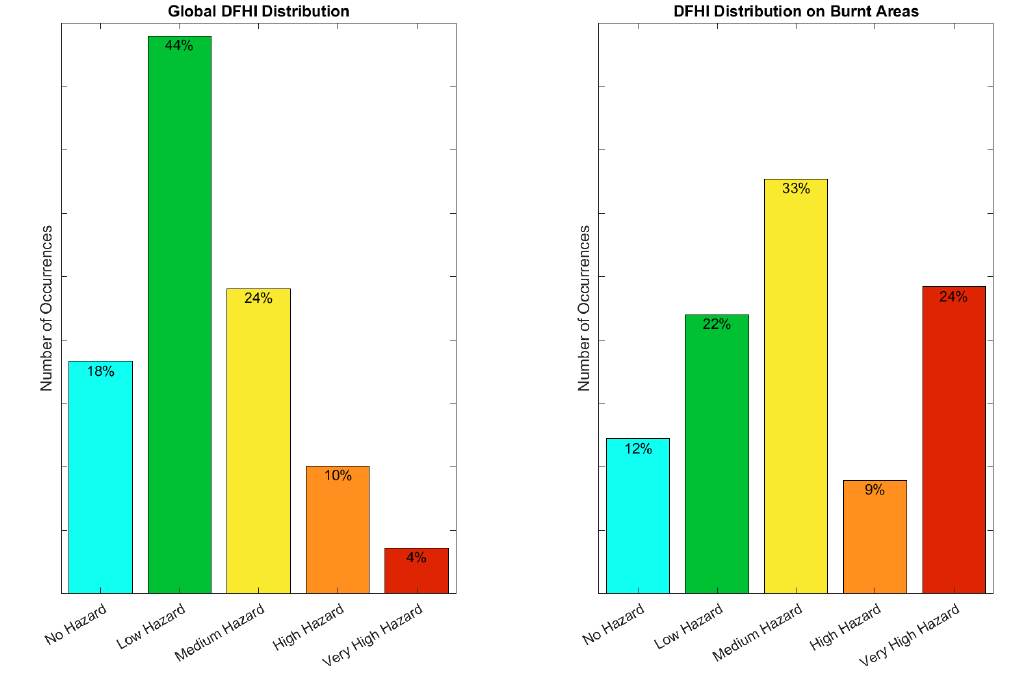
Figure 3. Distribution of the DFHI on the entire Area Of Interest (AOI) ( left ) and only on burnt areas ( right ) without applying temperature